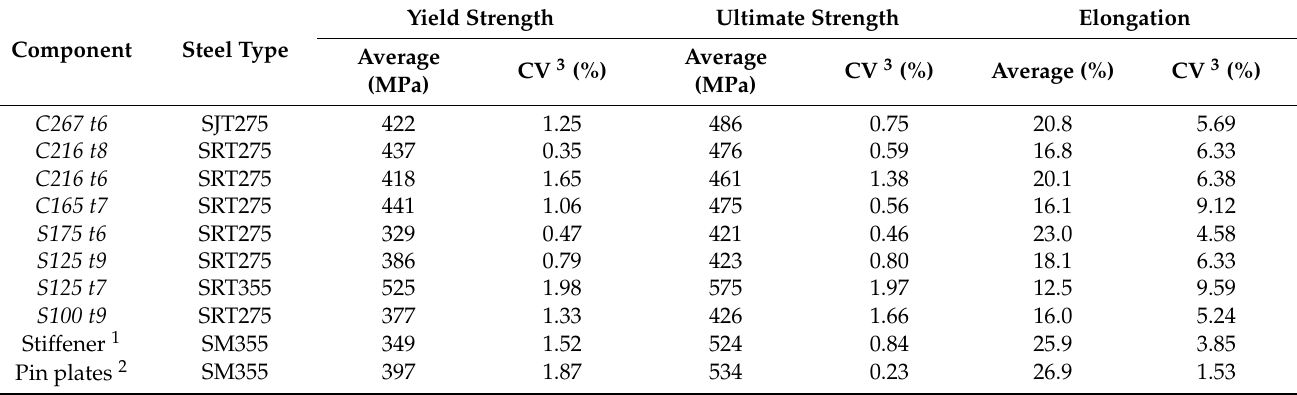
Table 2. Material